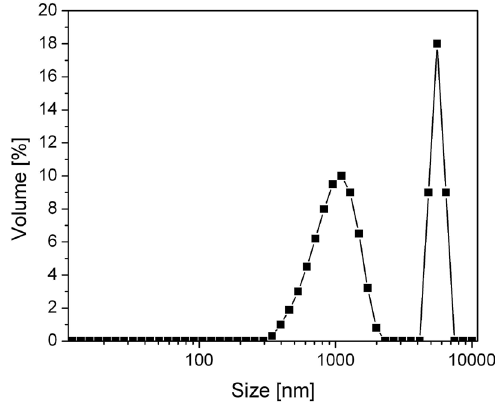
Figure 15. The effect of pH on the activity of native and immobilized lipase.